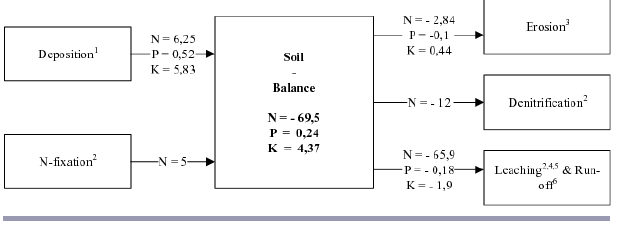
Farmland = input − output ± ∆ soil [g / capita * a] where input is the sum of compost, clay, coal, and human excreta, output is harvest, and ∆ soil refers to the soil dynamic parameters (Fig. 2). All calculations of the scenarios were calculated per person, which means that the field of 0.42 ha was split into 5.5 portions (the number of persons of the participating family), leading to an area of 764 m² for each person. If not explicitly stated, all data is related to dry matter. Fig. 2 . Soil nutrient dynamics [kg/ha a ⁻ ¹] of the investigated farmland without human activities, like harvesting or fertilization. Their calculation is based on data taken from the following literature: ¹Boy et al. 2008; ²FAO 2003; ³estimated according to Wiersum 1984; ⁴ Long et al. 2015; ⁵ Blum et al. 2013; ⁶ Howeler 2001.